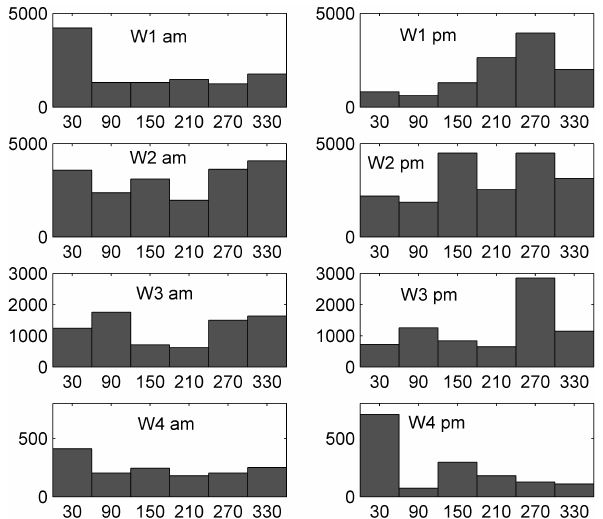
Fig. 2. Histograms of wind direction observed at 9:00 a.m. (left column) and 3:00 p.m. (right column) for four selected wind ob- servation sites (W1, W2, W3, and W4 in Fig. 1). Horizontal axis shows bin centres of the wind direction in degree clockwise from the north. The data were collected by BOM in 1977–2008, 1957– 2008, 1987–2008, and 1965–1969 for the four sites, respectively.